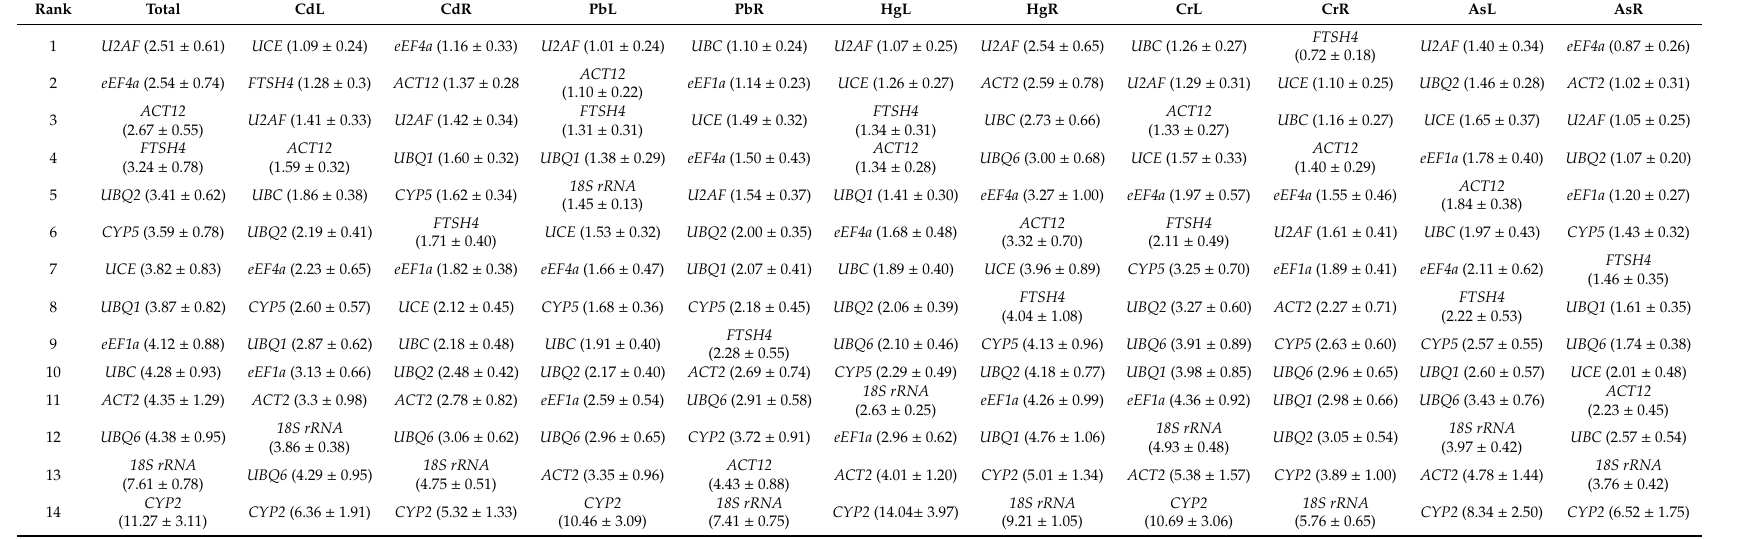
Table 1. Expression stability values for switchgrass candidate reference genes calculated by